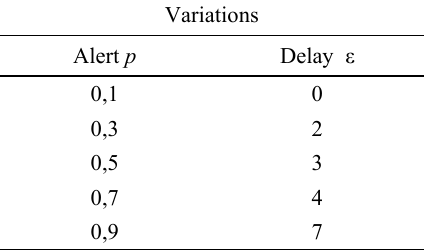
Table 3. Alert Delay model parameters.